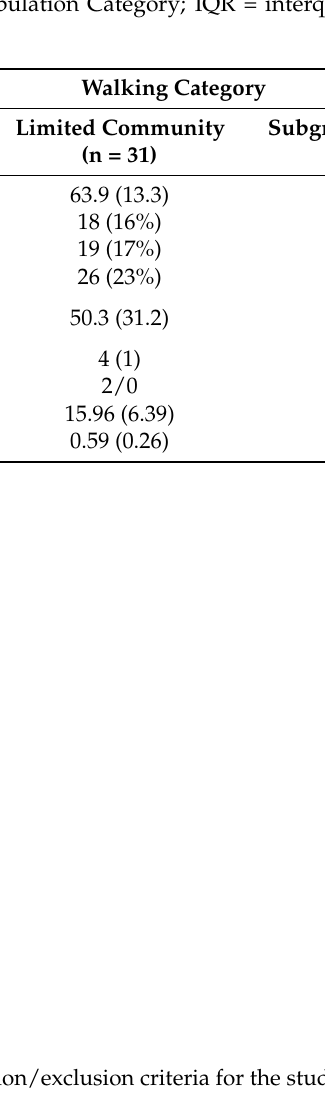
Table 1. Baseline demographics and overall stroke patient characteristics in total and separated by walking category. SD = standard deviation; PT = physical therapy; FAC = Functional Ambulation Category; IQR = interquartile range;